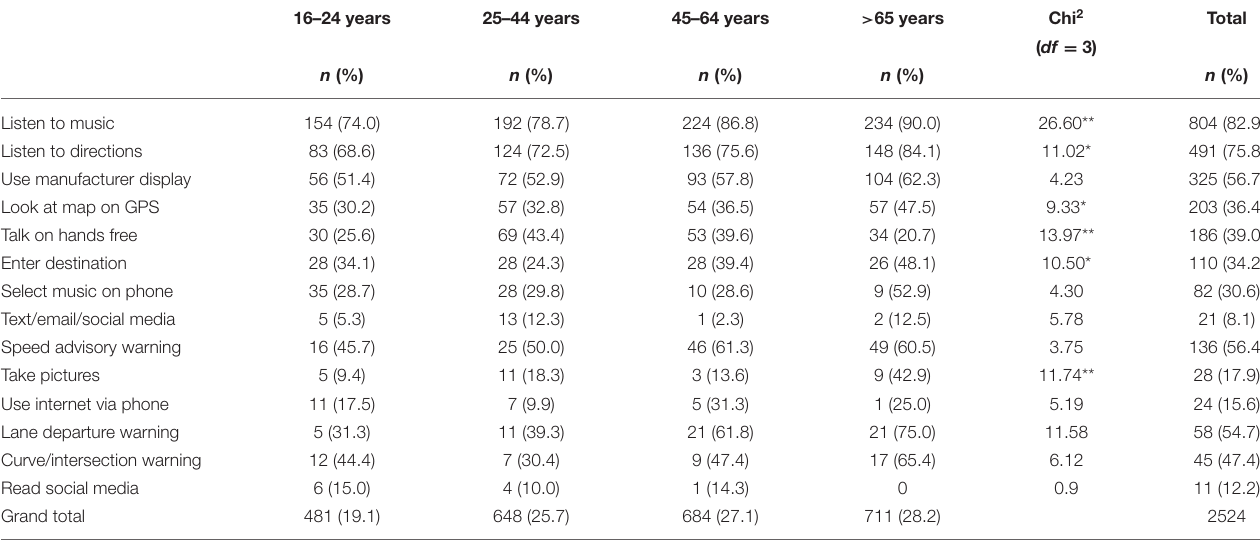
TABLE 6 | The number and percentage of respondents in each age group engaging in each IVIS behavior or event reporting that it had no effect on their